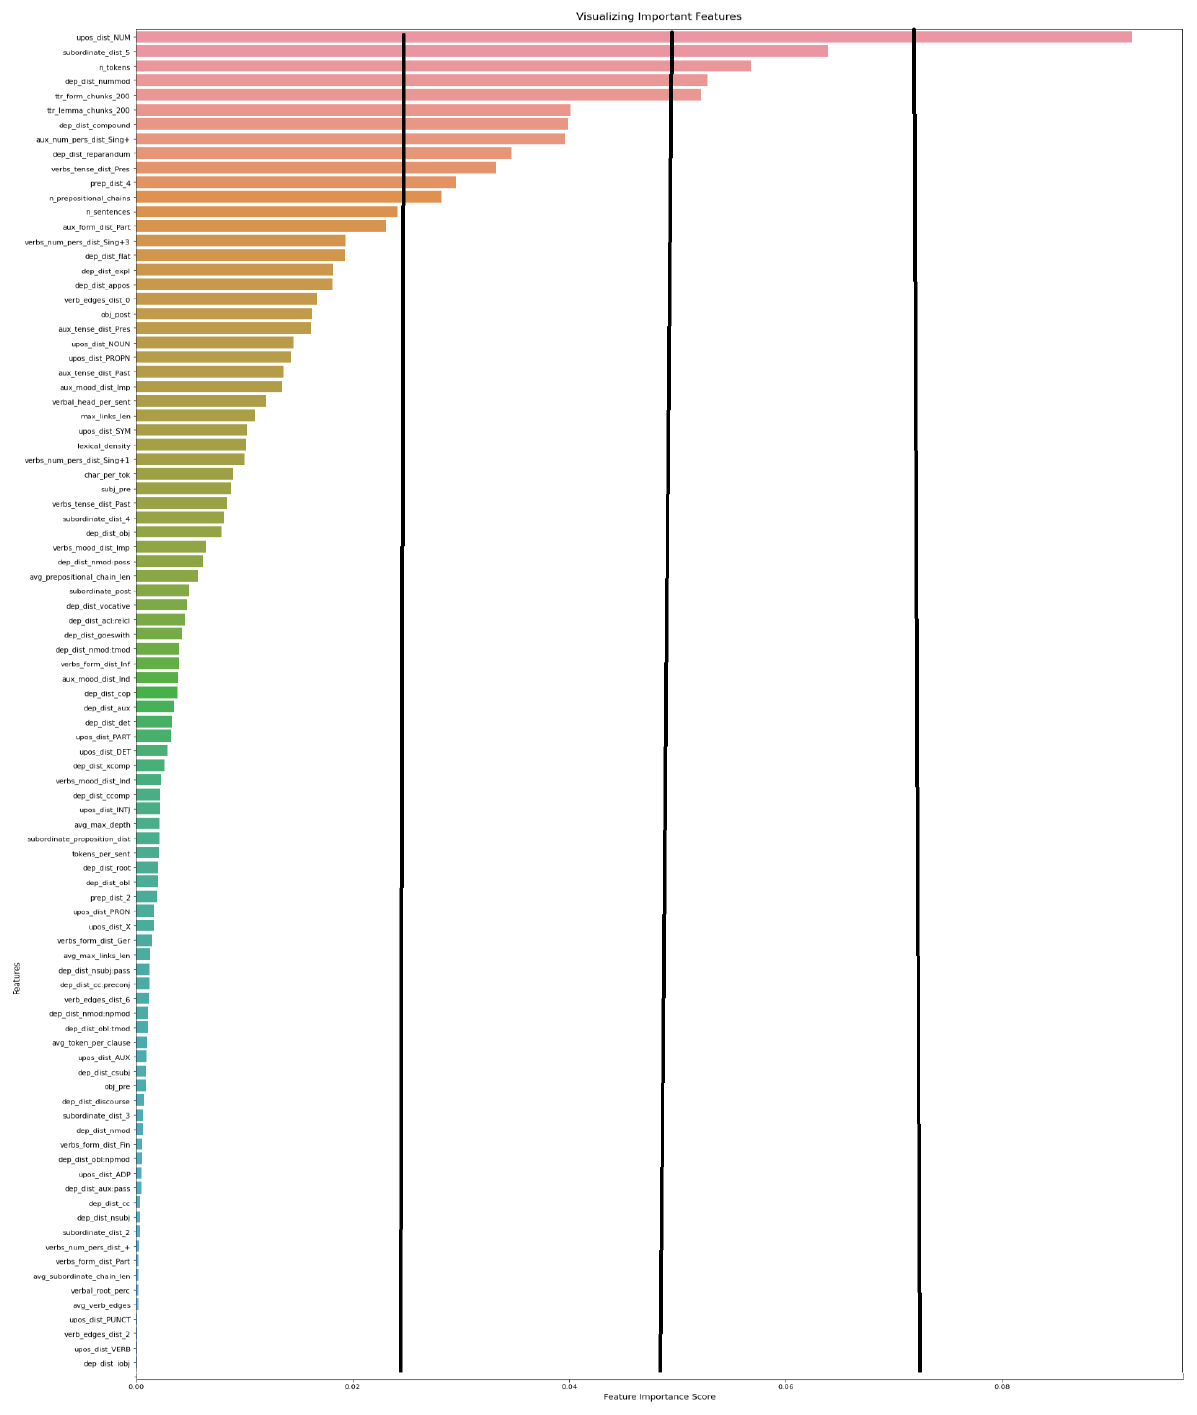
Figure 3. Variable importance plot of the RF sub-genre model. NOTE: The x-axis shows the permutation relevance (mean decrease in accuracy) of each feature; the y-axis lists the features of the sub-genre model.